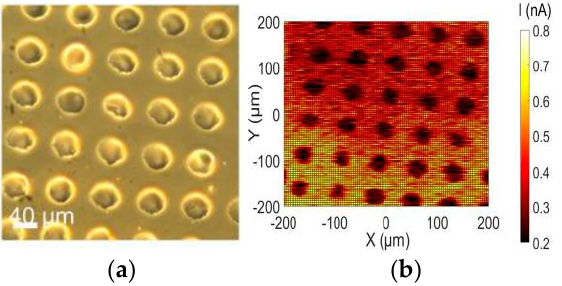
Figure 2. The mechanism of photoelectric conversion of CDs.